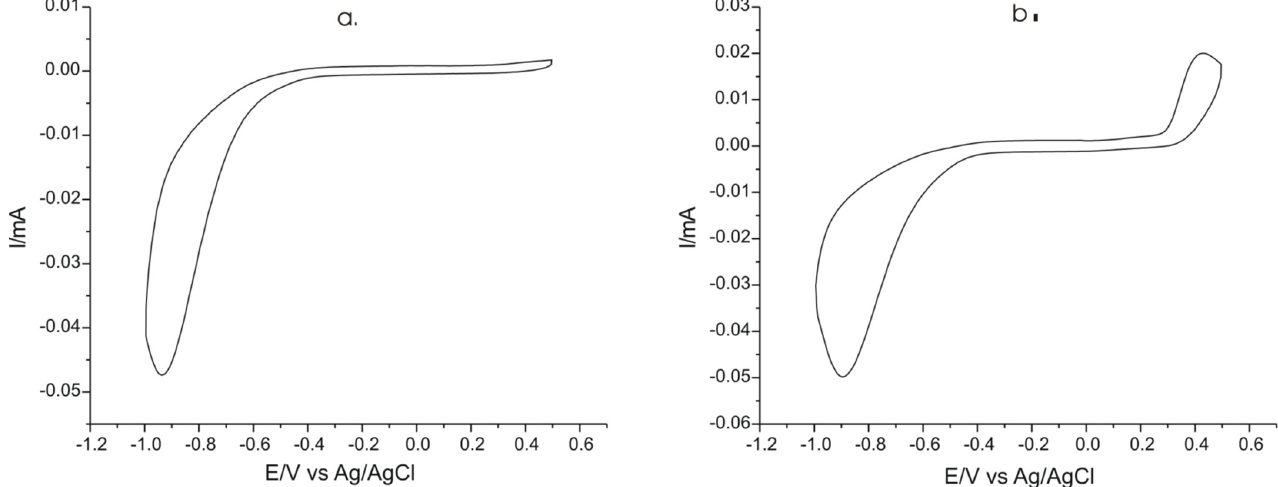
Figure 6. Electrochemical response of carbon screen-printed electrode immersed in: ( a ) 0.1 M KCl and ( b ) 0.1 M KCl and 10 − 3 M L-Tyr solution at 0.1 V × s − 1 .